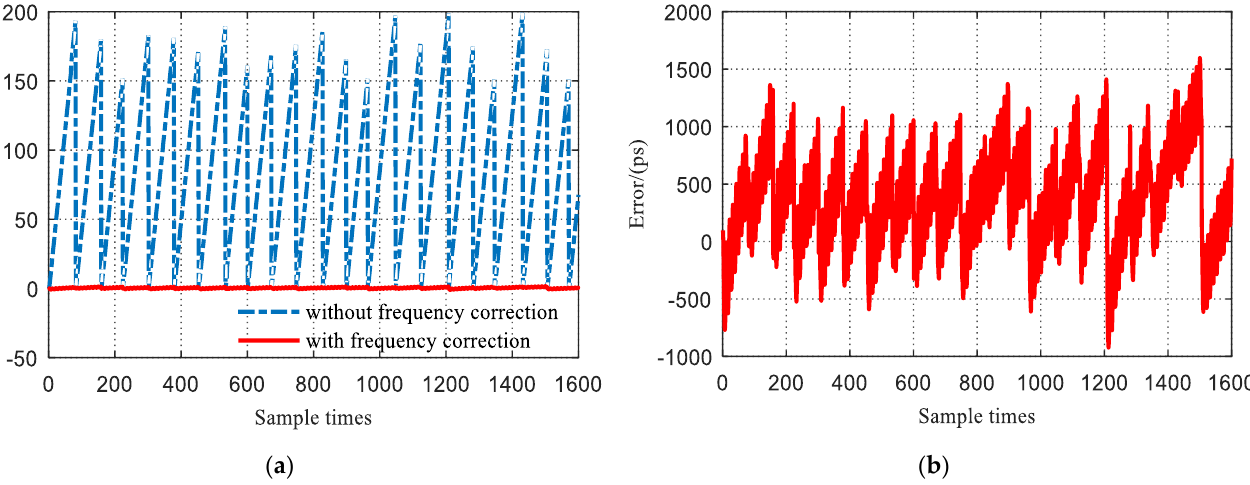
Figure 16. Experimental clock synchronization results: ( a ) synchronization error with frequency correction vs. without; ( b ) detailed view of the synchronization error with frequency correction (standard deviation = 431.60 ps).